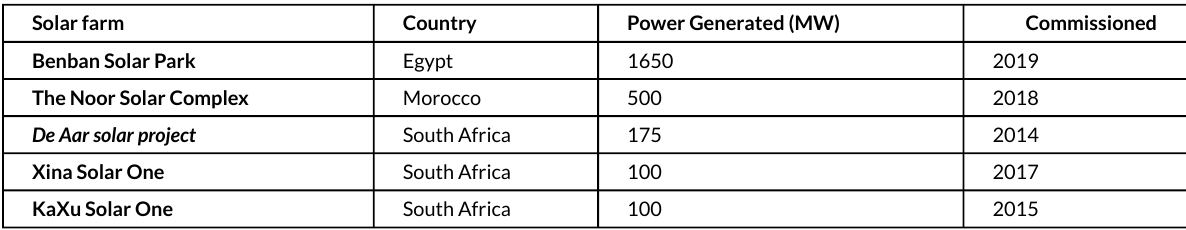
Table 7. The largest five solar farms in